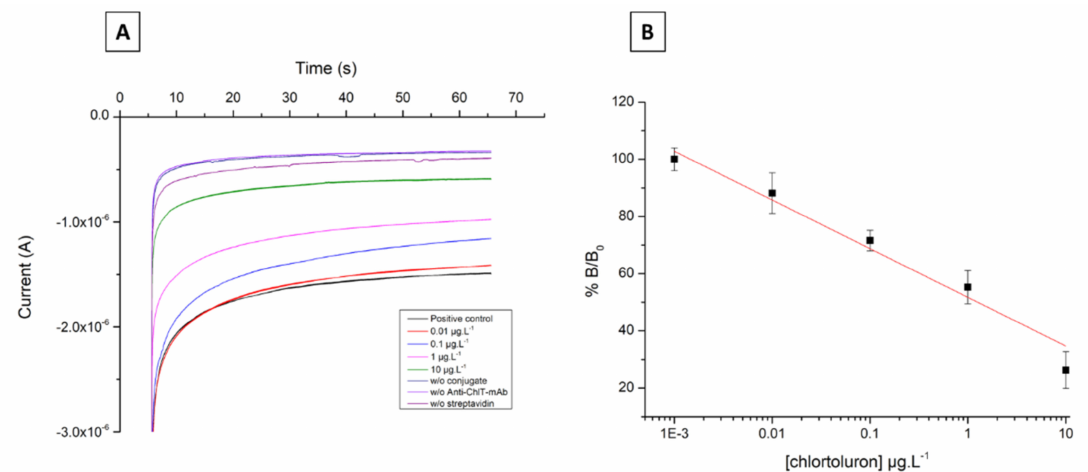
Figure 9. ( A ). Chronoamperograms recorded after incubation with chlortoluron concentrations at 0 (positive control), 0.01, 0.1, 1, and 10 µ g · L − 1 . Applied potential − 0.2 V vs. Ag/AgCl. Negative controls measured without streptavidin, conjugated chlortoluron, and primary antibody, respectively. ( B ). Calibration curve presenting %B/B 0 versus chlortoluron concentrations (R 2 =